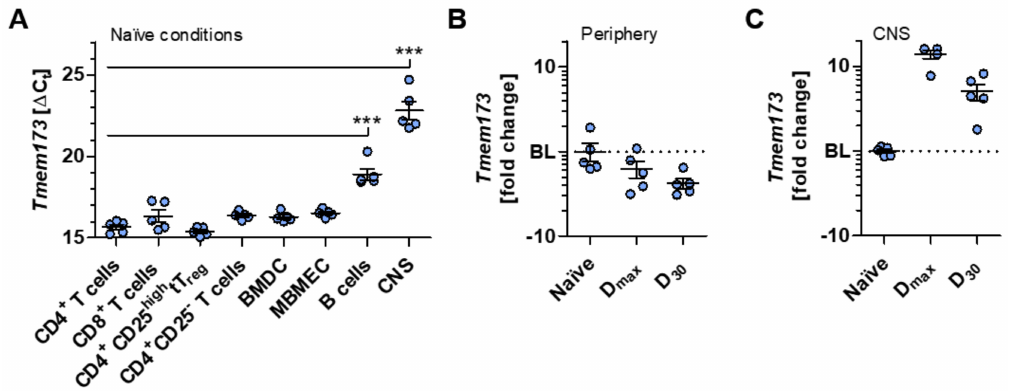
Figure 1. Sting is upregulated in central nervous system (CNS) tissue under neuroinflammatory conditions. ( A ) Quantitative real-time polymerase chain reaction (RT-qPCR) gene expression analysis of Tmem173 encoding the stimulator of interferon genes (STING) was performed in di ff erent immune or CNSresidentcelltypes. ∆ C t valuesareillustratedfortheindicatedcellsubsetsortissueofnaïveC57BL / 6J mice. ( B ) Fold change analysis of Tmem173 in peripheral lymphoid tissue of active experimental autoimmune encephalomyelitis (EAE)-induced C57BL / 6J mice is shown for days 16 (D max ) and 30 (D 30 ) post-immunization relative to naïve tissue. ( C ) Fold change of Tmem173 was calculated from thoracic spinal cords of EAE-induced C57BL / 6J mice at D max and D 30 post-immunization relative to naïve tissue. In ( B , C ), the mean corresponding ∆∆ C t value of the control group was normalized to 1 and set as the baseline (BL; displayed as dotted line), thus serving as a reference. Data in ( A – C ) are mean ± standard error of the mean averaged from five mice per condition performed with technical triplicates. Data in ( A ) were analyzed by one-way analysis of variance (ANOVA), and the level of significance was labeled as *** probability ( p ) < 0.001. Abbreviations: Thymus-derived regulatory T cells (tT reg ), bone marrow-derived cells (BMDC), murine brain microvascular endothelial cells (MBMEC)